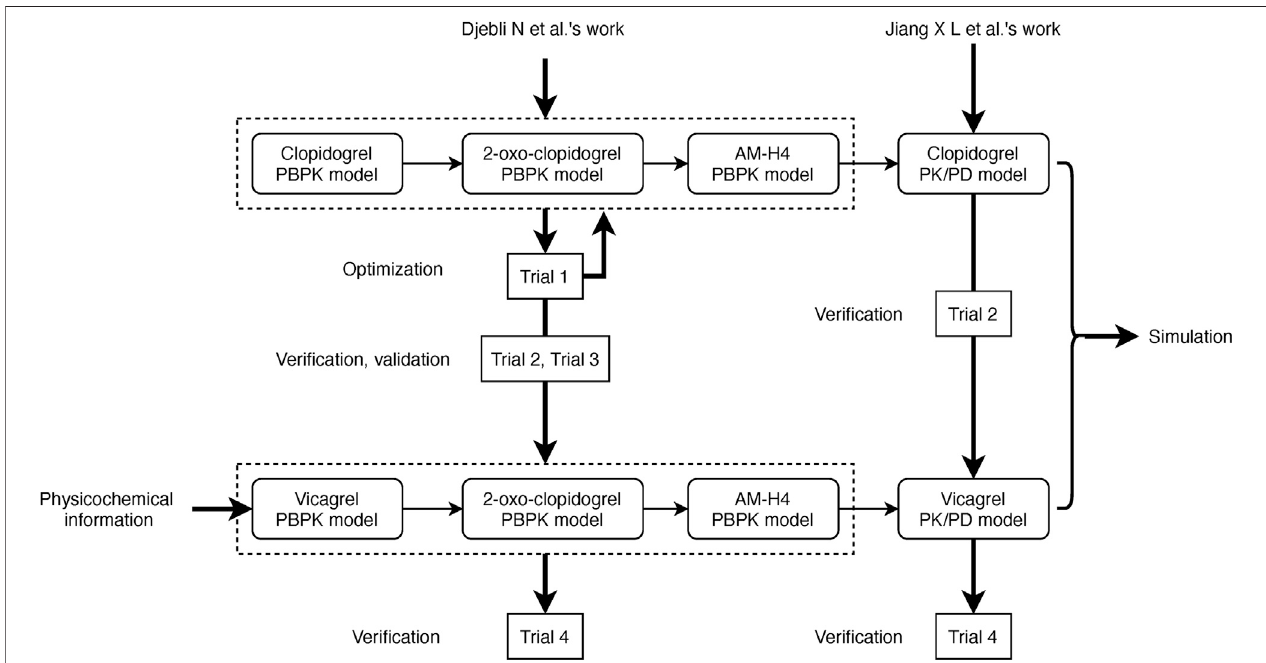
FIGURE 1 | Scheme of development, veri fi cation, and validation of PBPK/PD models for vicagrel and clopidogrel.